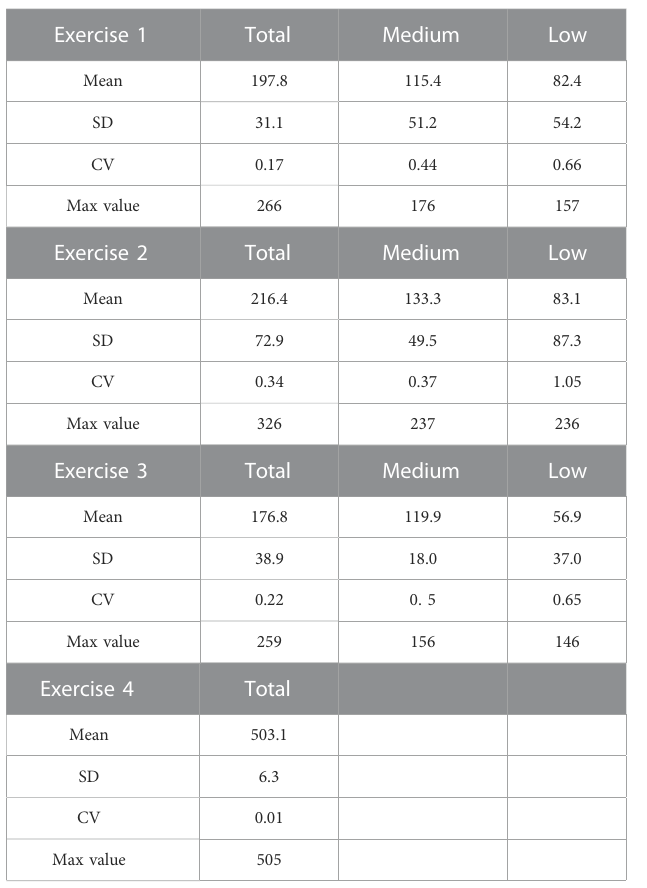
TABLE 4 Total, medium, and low activity counts during each individual exercise in the 14 healthy subjects.